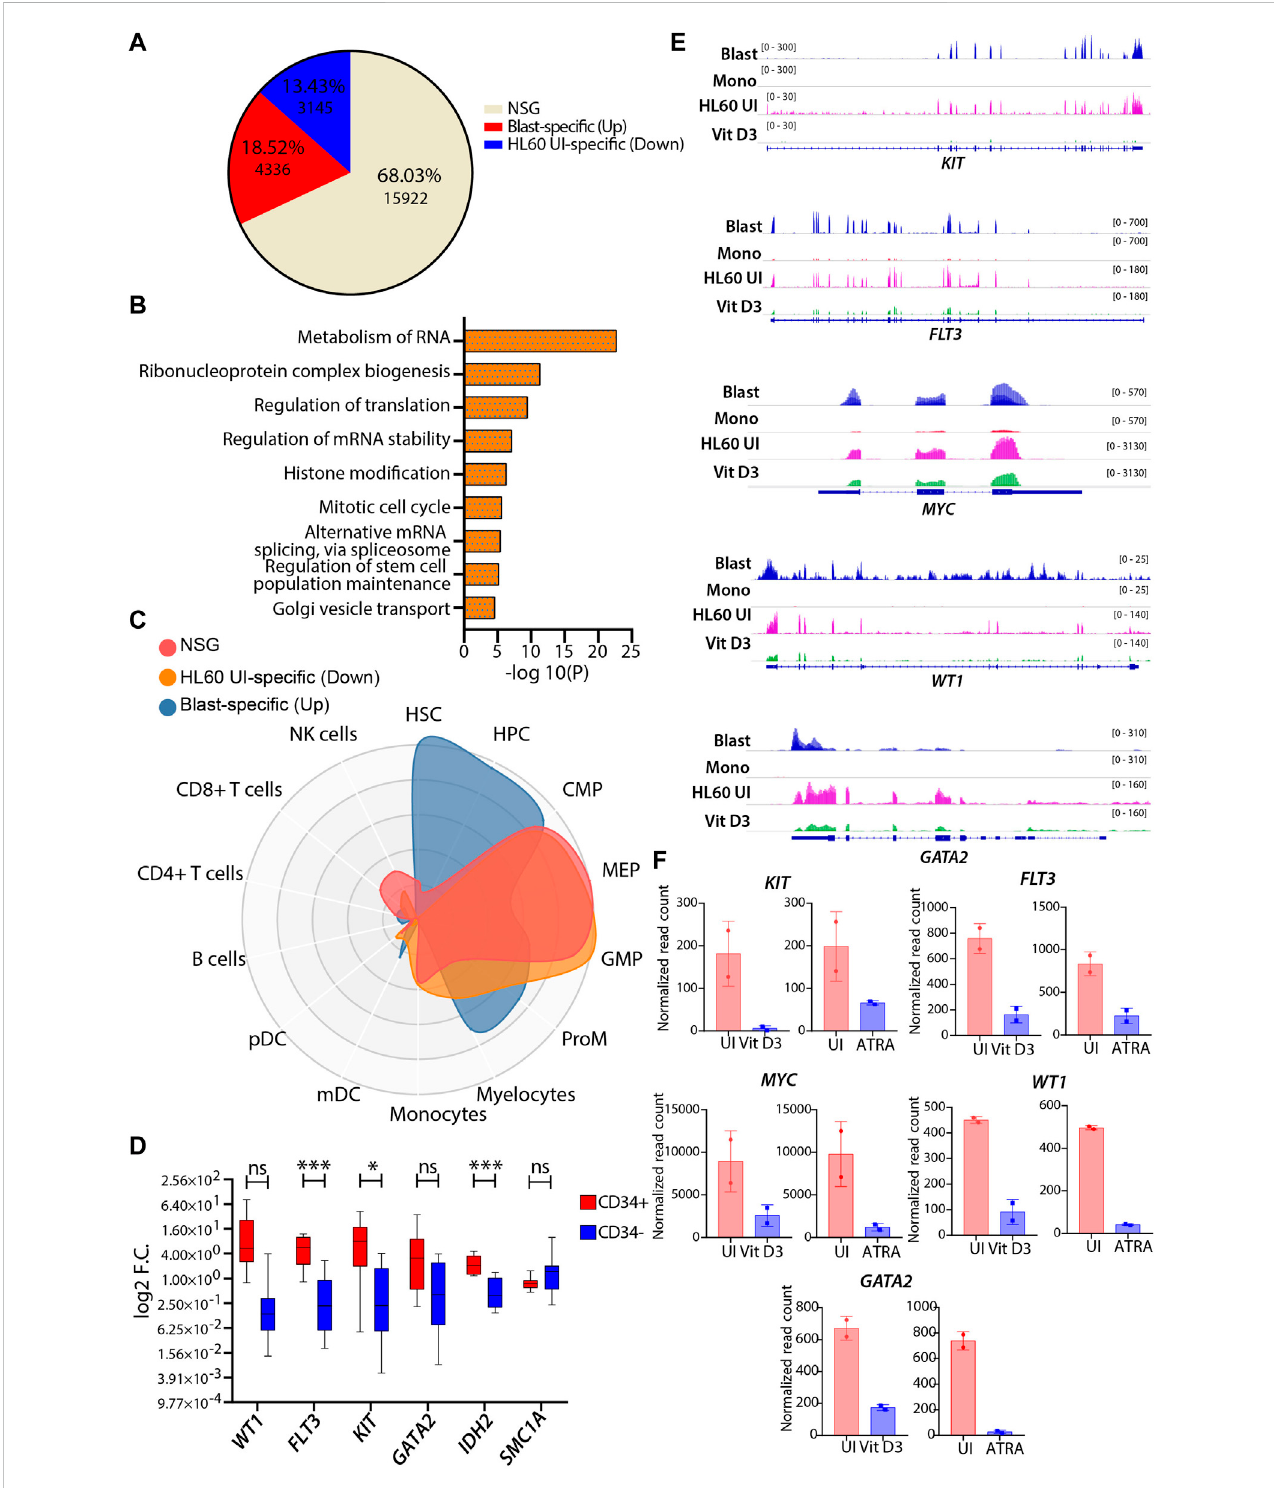
Comparative transcriptomic pro fi les of uninduced HL60 and leukemic blasts derived from patients with AML. (A) Venn diagram representing the differentialgeneexpressionpro fi leofHL60uninducedcellwithprimaryAMLblast.Thedifferentialgeneexpressionanalysisresultedinupregulatedgenes( > 1- fold change, 13.43%, n = 3145, adjusted p -value ≤ 0.05), downregulated genes ( < 1-fold change, 18.52%, n = 4336, adjusted p -value ≤ 0.05) and genes that did not satisfy |log2FC| > 1 and FDR < 0.05 (NSG) (68.03%, n = 15922). (B) Bar plots showing the enriched pathways (signi fi cance -log10 as the p -value) for the NSG genes. (C) CellRadar plot highlighting the overall relatedness between the primary AML blast and uninduced HL60 cells. (D) RT - qPCR validations of the genes upregulated in the AML like WT1, FLT3, KIT, GATA2, IDH2, and SMC1A in the primary AML CD34 positive and negative cells. (E) Representative IGV plots showing the gene expression pro fi le of the leukemia-associated genes, KIT, FLT3, MYC, WT1, and GATA2 in the primary AML blast cells (n = 8), primary monocytes (n = 4), uninduced HL60 (n = 2) and Vit D3-induced monocytes (n = 2). (F) Bar graphs showing the normalized read count values from this study ( n = 5) of above-mentioned leukemia-associated genes in the uninduced HL60 and Vit D3 and ATRA-induced